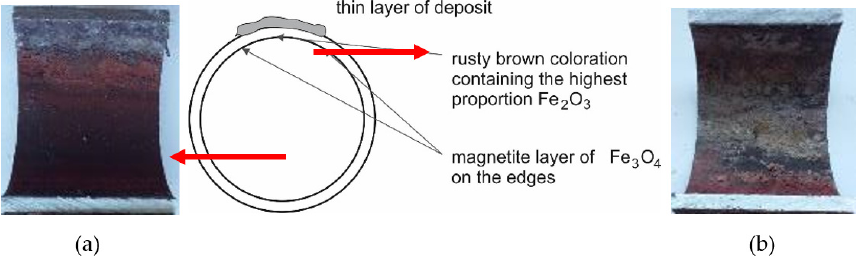
Figure 5. The inner surface of the cutout 2 tube with the deposit: ( a ) the lower part of the tube; ( b ) the upper part of the tube placed under the deposit according to Figure 5b.